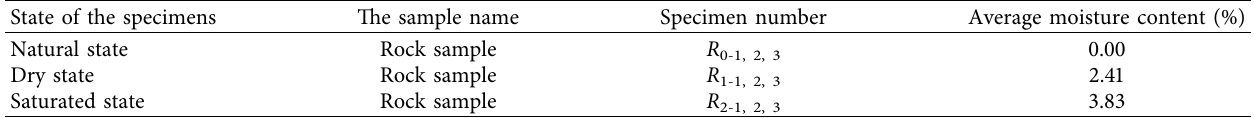
Table 1: Sample number and moisture content in each state.